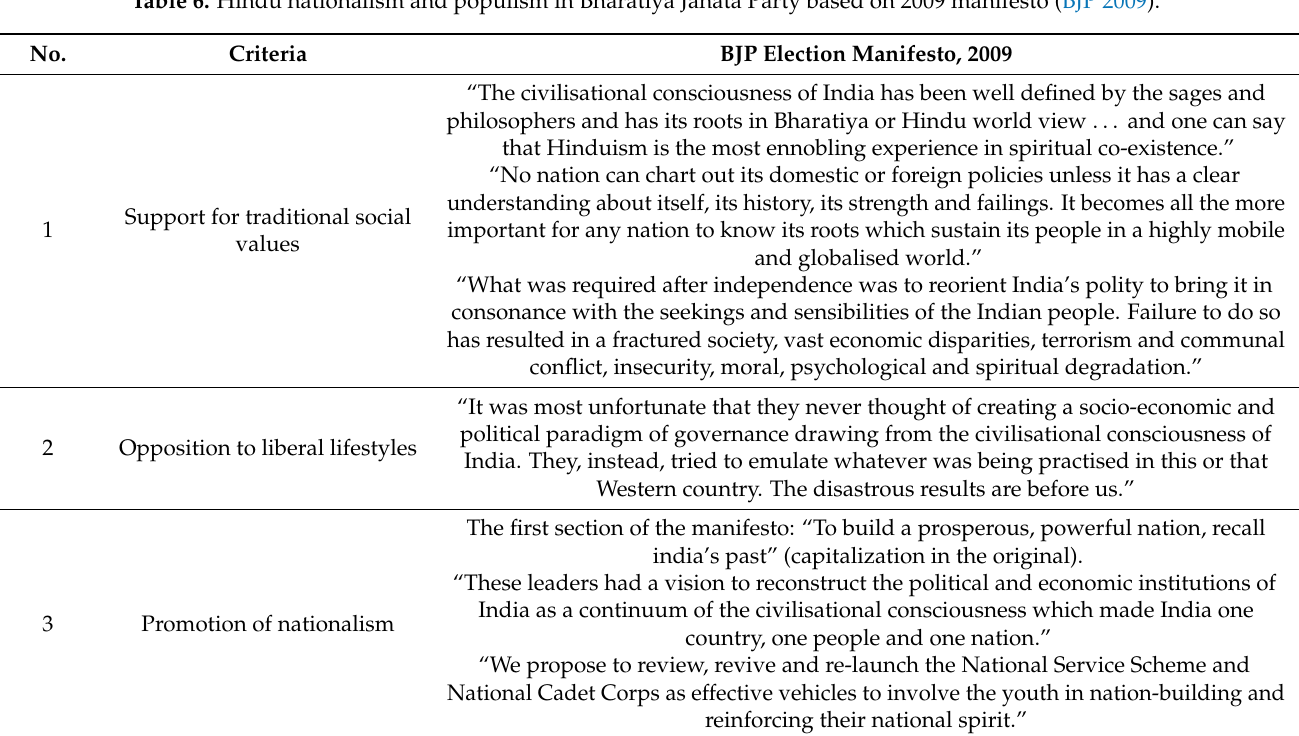
Table 6. Hindu nationalism and populism in Bharatiya Janata Party based on 2009 manifesto (BJP